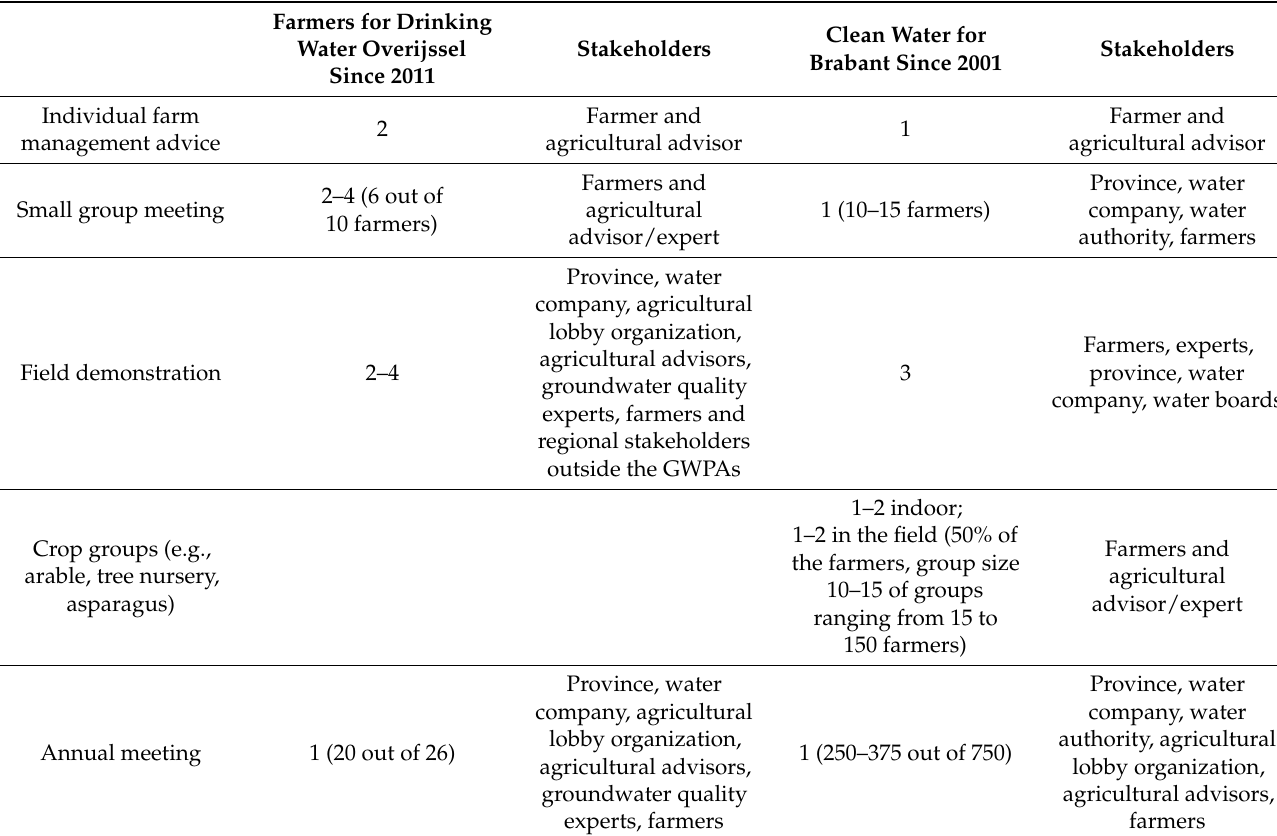
Table 1. Overview of yearly engagement activities and meetings in the case studies of Overijssel and Brabant. The participation rate is in